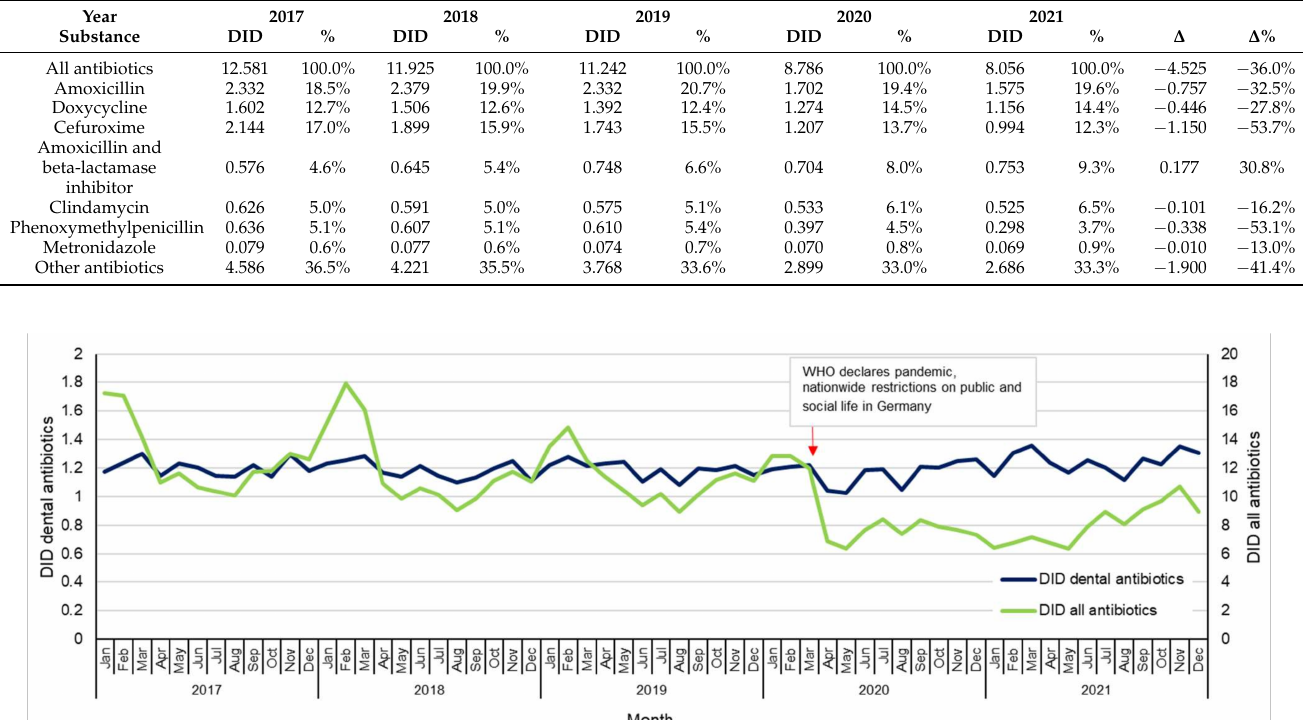
Figure 1. Prescription of systemic antibiotics in dental and primary care overall from January 2017